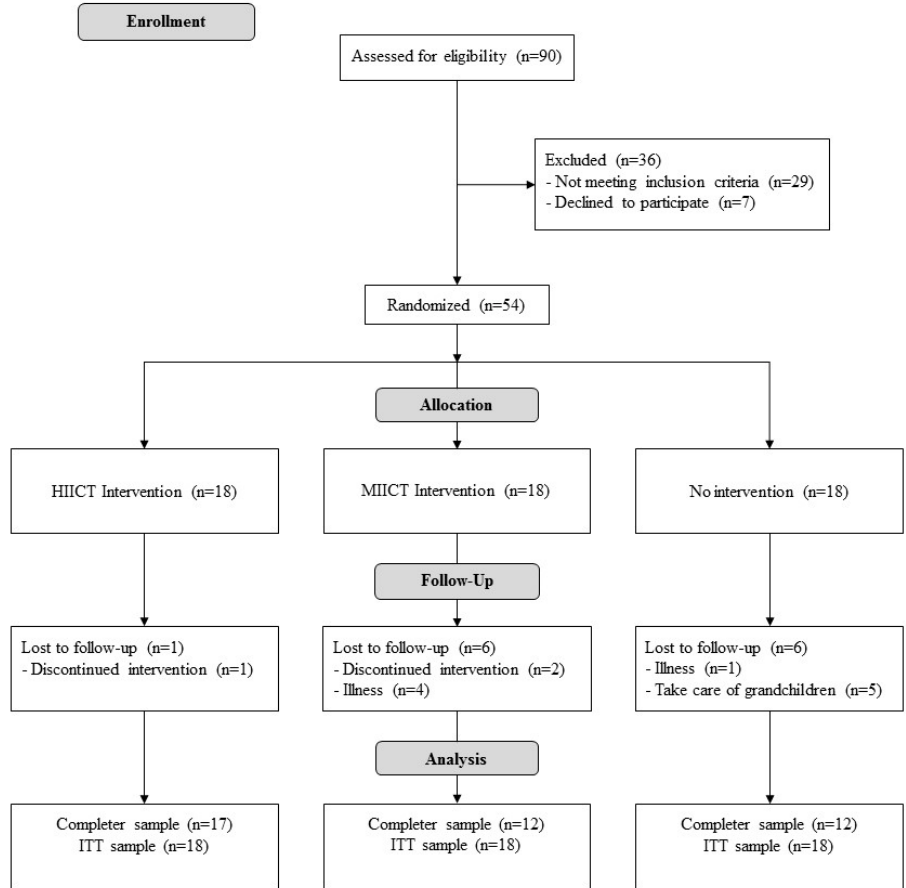
Figure 1. Flow diagram of the progress of the randomized trial. Table 3. Characteristics at baseline ( n = 56).